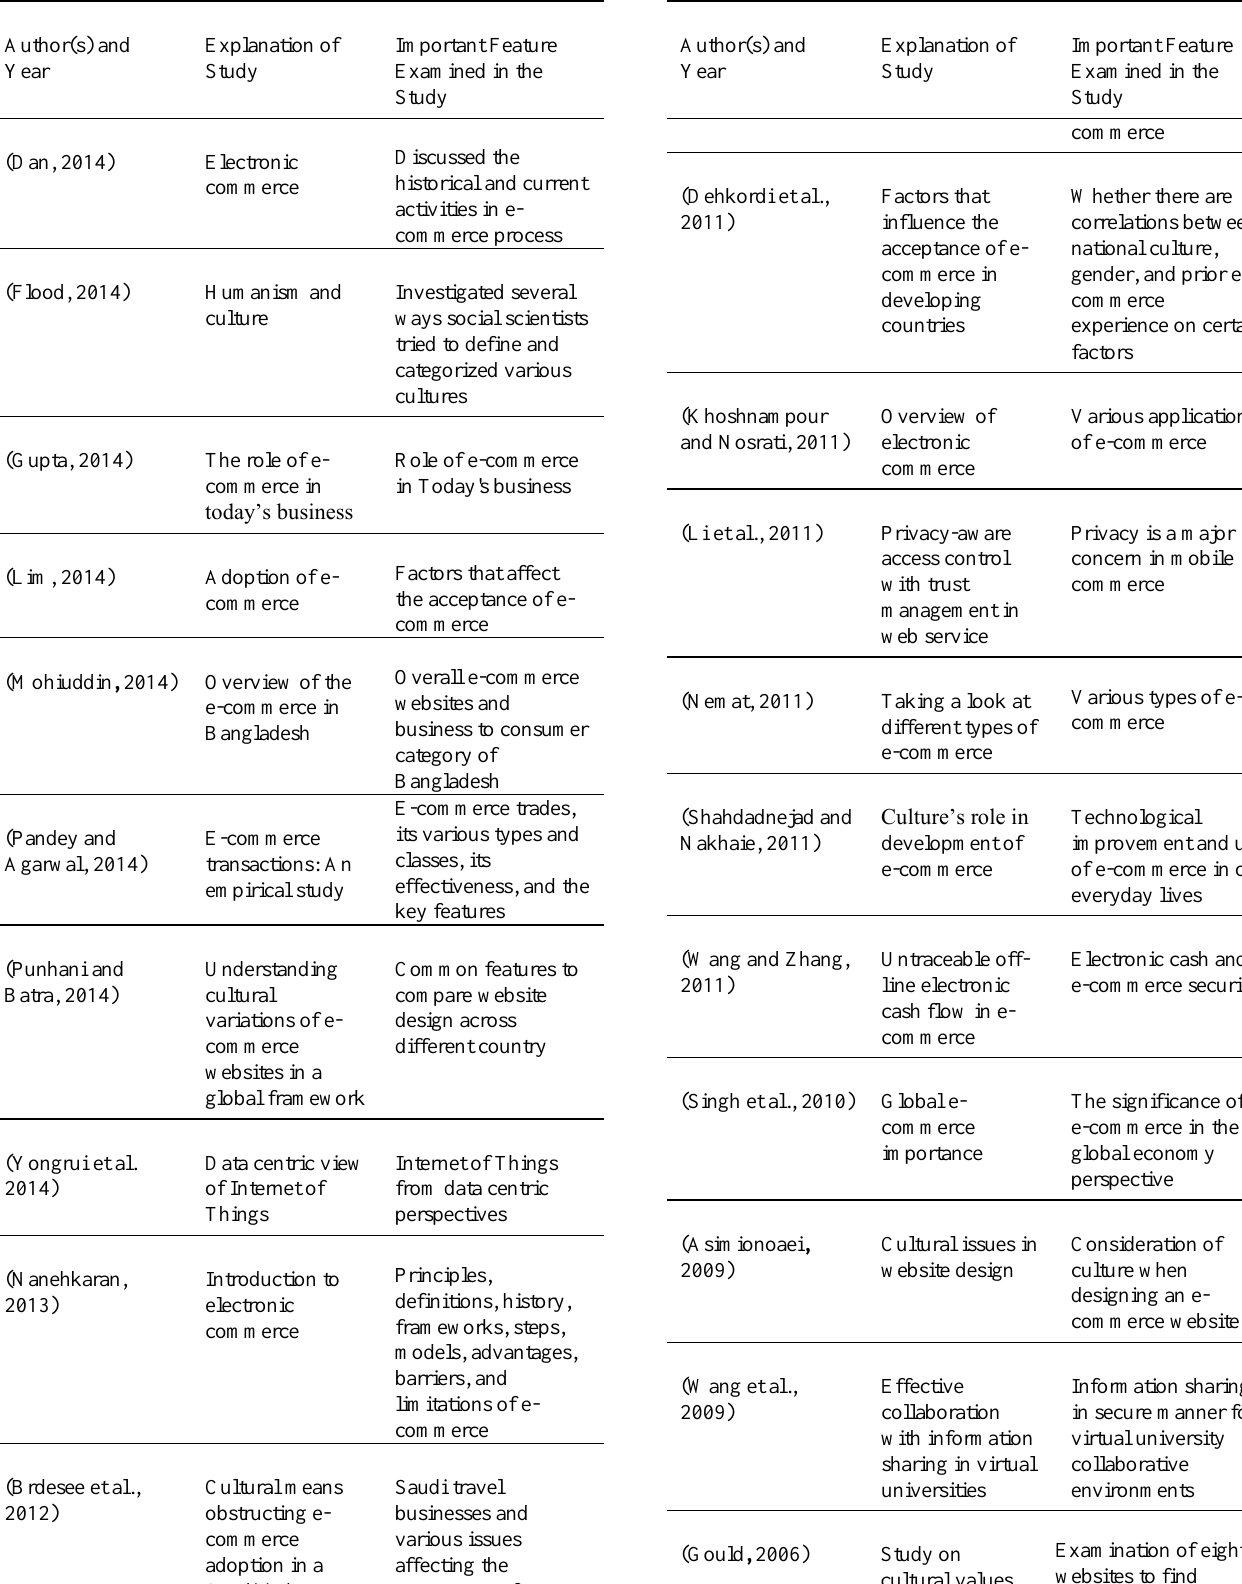
Table 3: A Summary of Selected Studies in Culture,